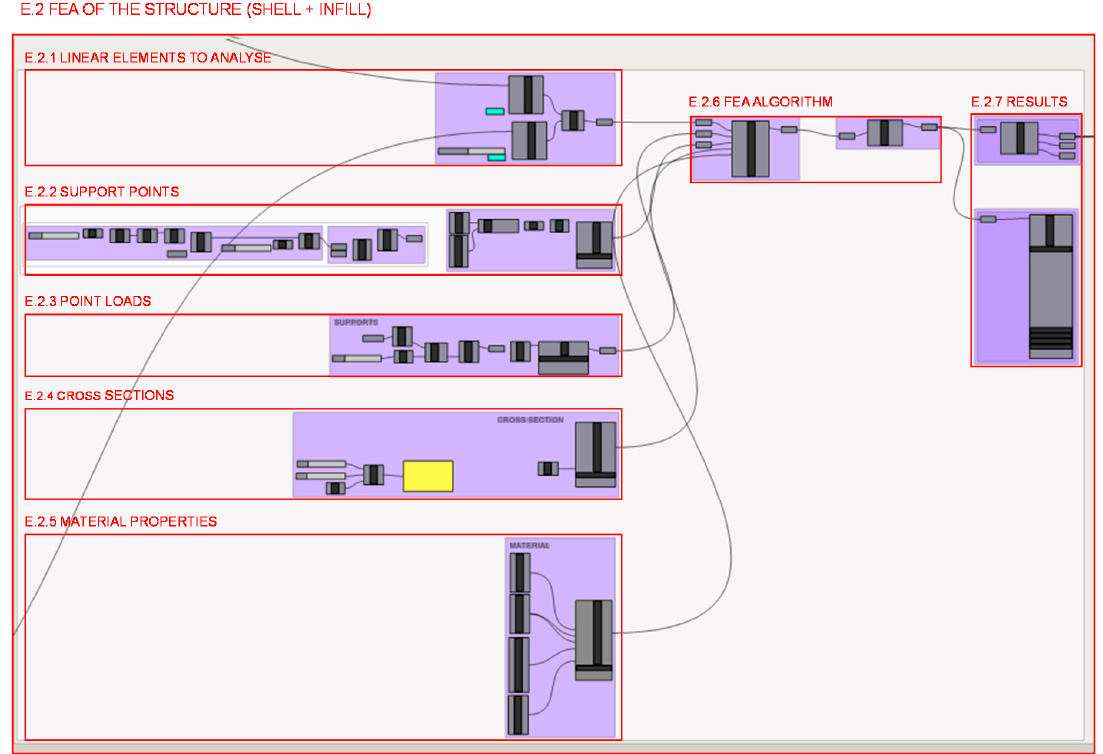
Figure 29. Programming structure definition developed for the FEA of the lattice structure of the heel infill and shell.